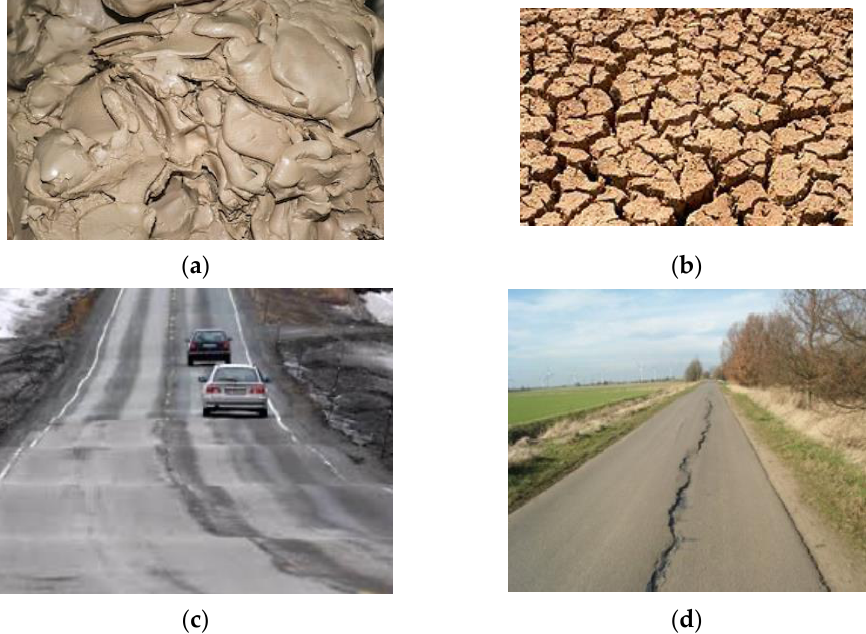
Figure 1. ( a ) Typical wet expansive soil [3]; ( b ) typical dry expansive soil [3]; ( c ) uplifting of flexible